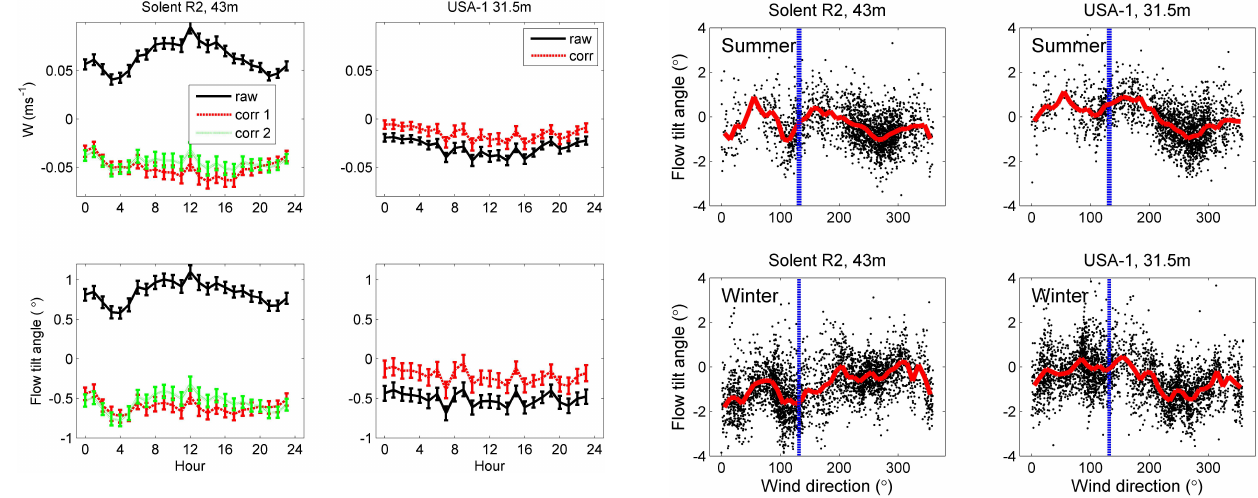
Fig. 4. Effect of flow distortion corrections on mean daily courses of Fig.4. Effectofflowdistortioncorrectionsonmeandailycoursesofmeanverticalvelocitiesandflowtiltanglesforallwinddirectionsand stabilities. mean vertical velocities and flow tilt angles for all wind directions and stabilities. Table 2. Vertical wind parameters evaluated for T =1800s from the Solent R2 10Hz data for westerly wind directions. L = U T (see Eq. 4) is the integral length scale.